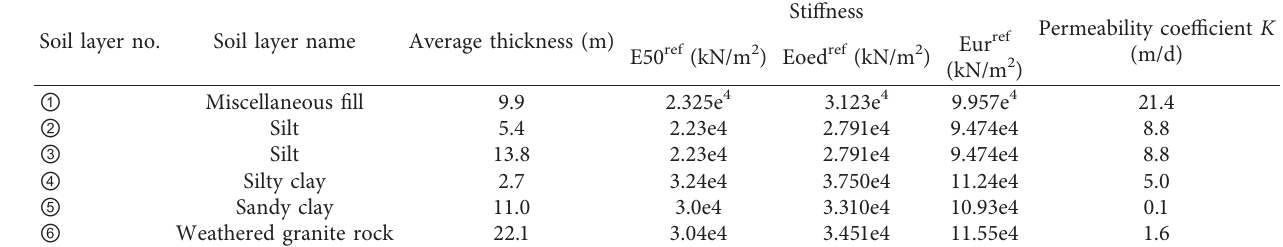
Table 2: Soil parameters.